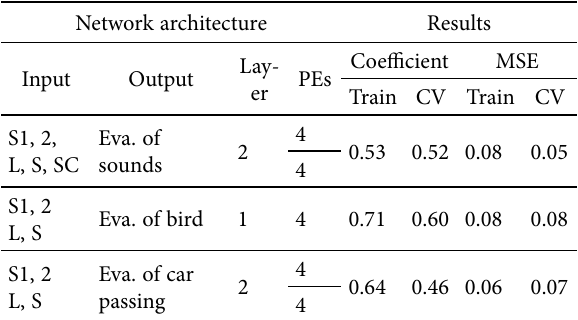
Table 4. Lab models in predicting the sound preference evaluations Network architecture